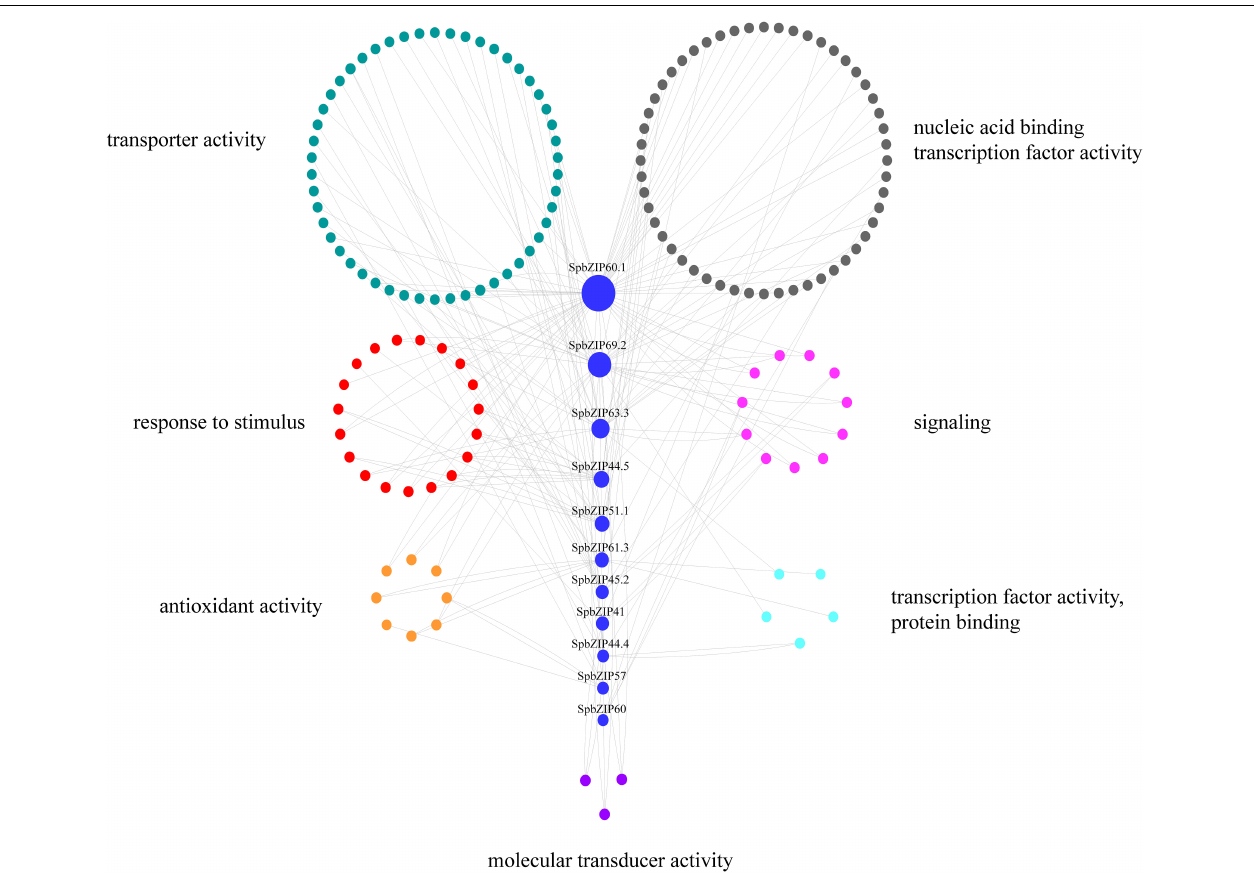
FIGURE 8 | SpbZIP gene co-expression network. The genes are divided on the basis of the following seven GO terms, which are represented by different colors: transporter activity, nucleic acid binding transcription factor activity, response to stimulus, signaling, antioxidant activity, protein binding transcription factor activity, and molecular transducer activity.